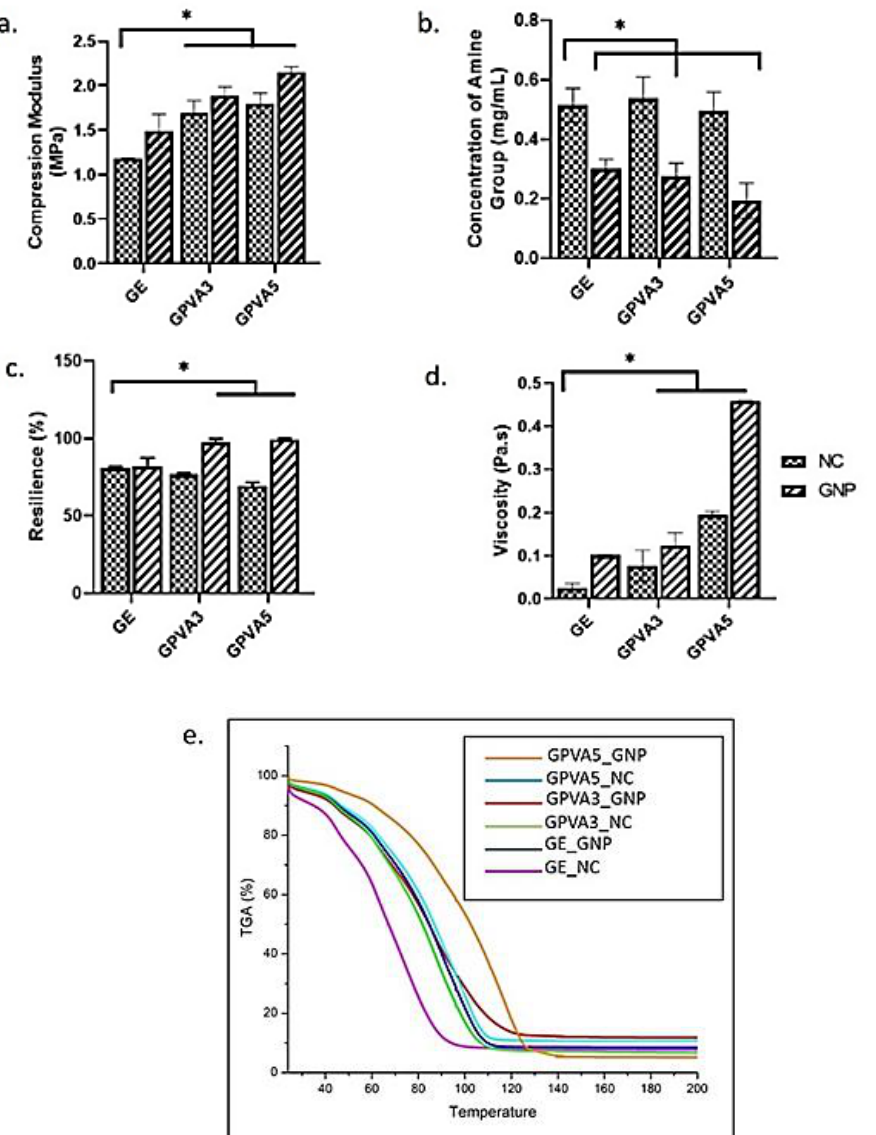
Figure 4. Mechanical properties analysis of gelatin, GPVA3, and GPVA5: ( a ) compression modulus, ( b ) concentration of amine groups, ( c ) percentage of resilience, ( d ) viscosity, and ( e ) TGA analysis, where * indicates p <0.05.